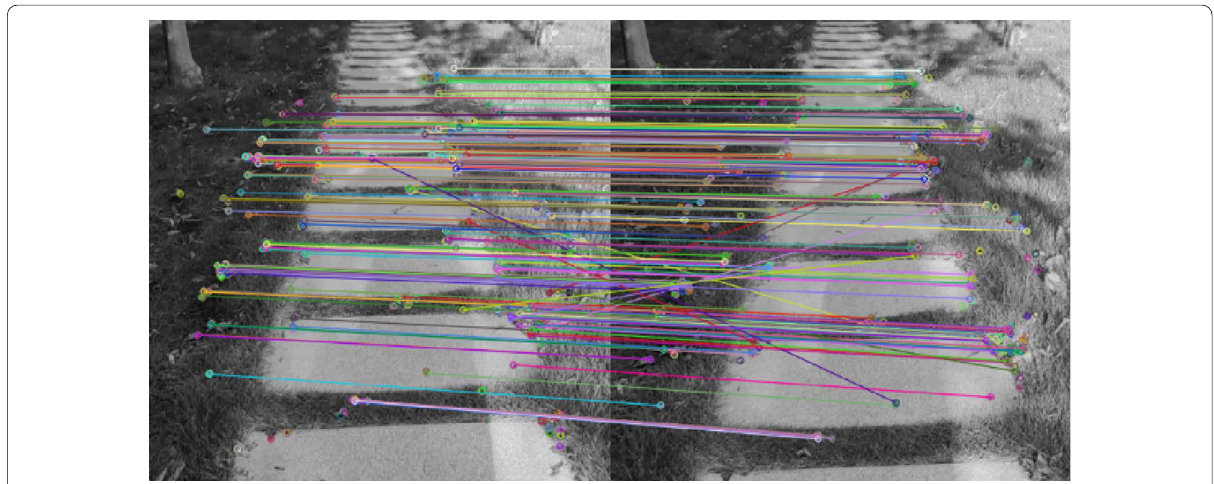
Figure 2 Feature point detection and matching